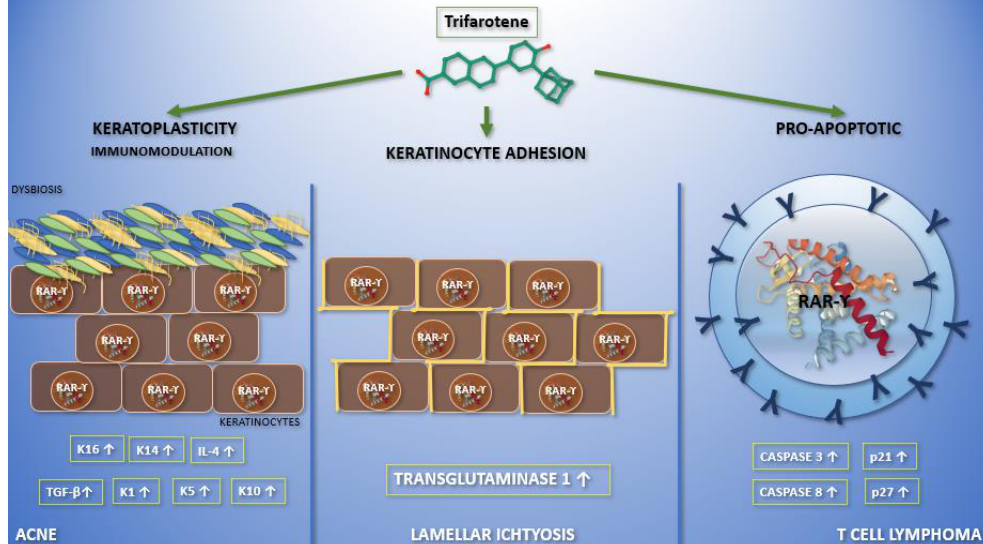
Figure 1. Graphic abstract representing the current applications of trifarotene in dermatological clinical trials and molecular pathways. In the left section, the action of trifarotene in acne is reported. It performs both immunoregulatory—leading to an increase in the expression of transforming growth factor-β and interleukin-4—and keratoplastic functions, increasing the expression of keratins K1, K5, K10, K14, and K16. Moreover, it seems that trifarotene, like other retinoids, may have a role in modulating skin microbiota. Finally, trifarotene weakens hemidesmosomes, interfering with cell adhesion. The migration of keratinocytes, caused by the drug, mediates its comedolytic property. The importance of trifarotene in lamellar ichthyosis has been reported in the central section. Trifarotene, by means of RAR-γ, causes an increased expression of transglutaminase 1, promoting keratinocyte cohesion. The rationale for the use of trifarotene in cutaneous T cell lymphomas has been reported in the right section. It seems to promote apoptosis and differentiation, upregulating caspases 3 and 8, p21 and p27.